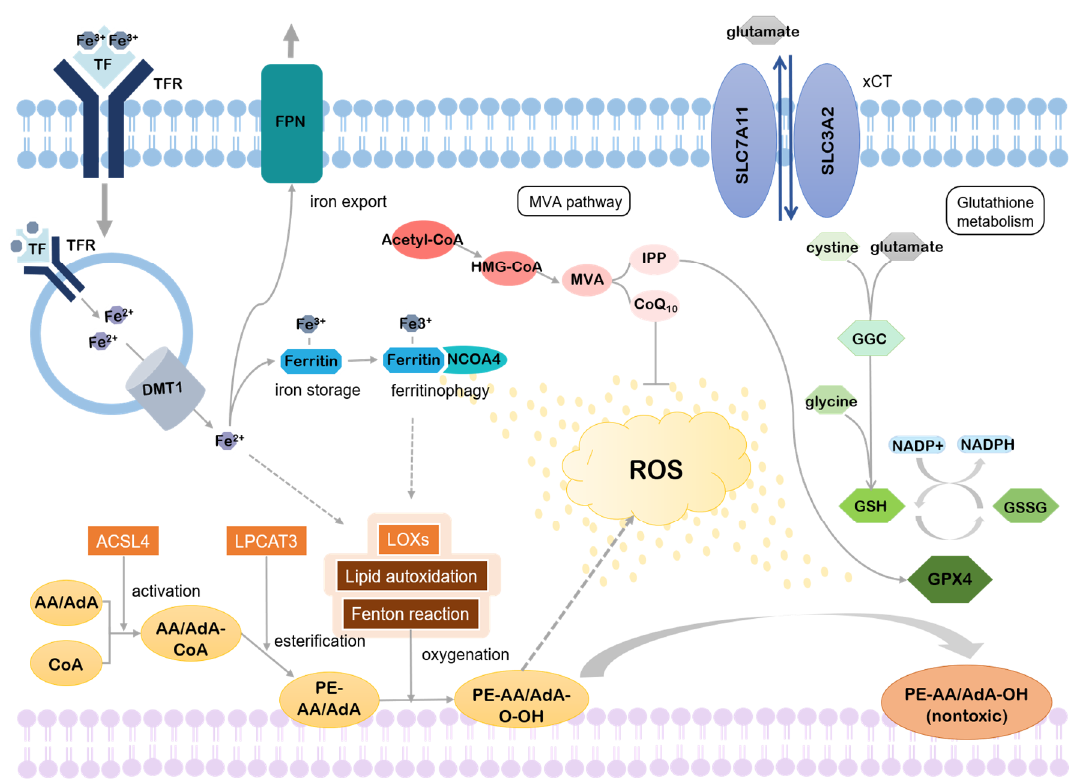
Figure 1. Mechanism of ferroptosis. Iron-dependent accumulation of lipid peroxides promotes ROS production, causing ferroptosis. By-products of the mevalonate pathway and glutathione metabolism, however, can rescue ferroptosis.